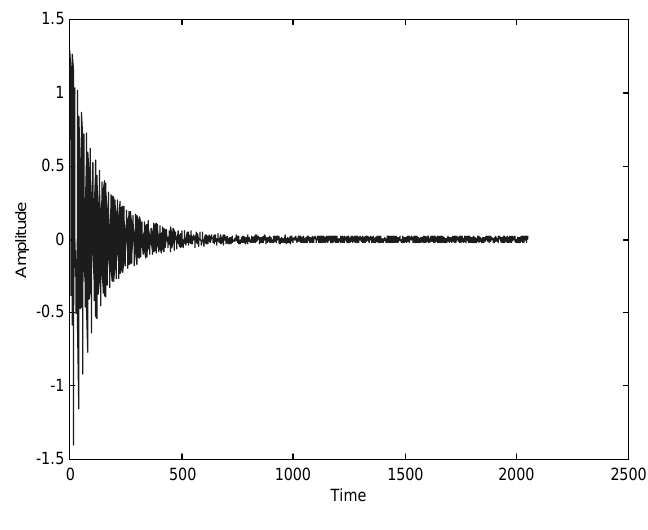
Fig. 1. Typical Impulse Response with 10% Noise/Signal